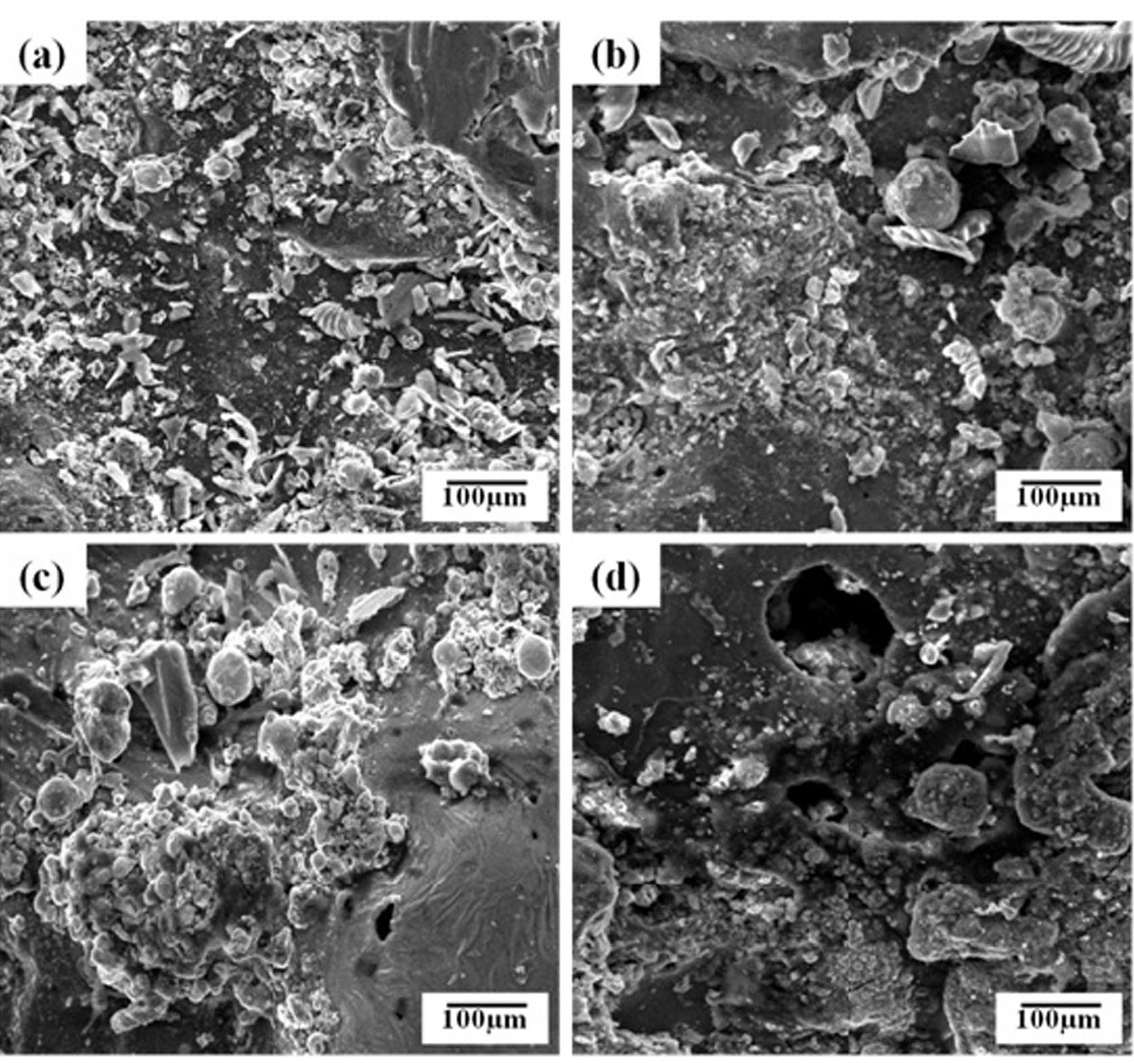
Figure 4: SEM microstructure (a, b) uniform deposition at high compaction load fully sintered electrode; (c) lump deposition at low com- paction load partial sintered electrode; (d) craters at low compaction